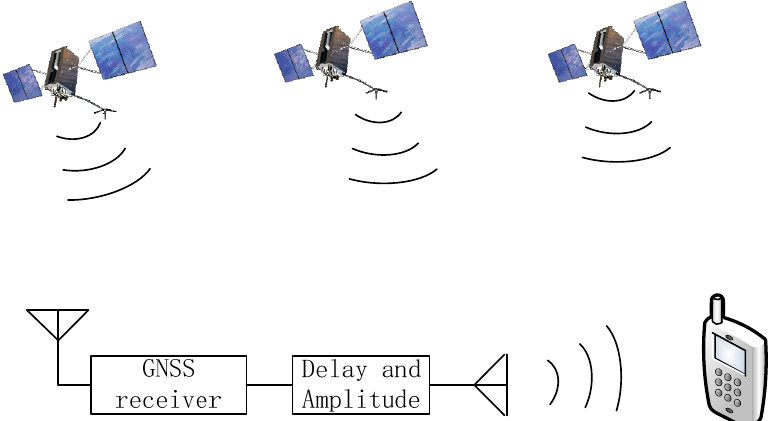
Figure 4. Generation principle of forwarding spoofing interference.